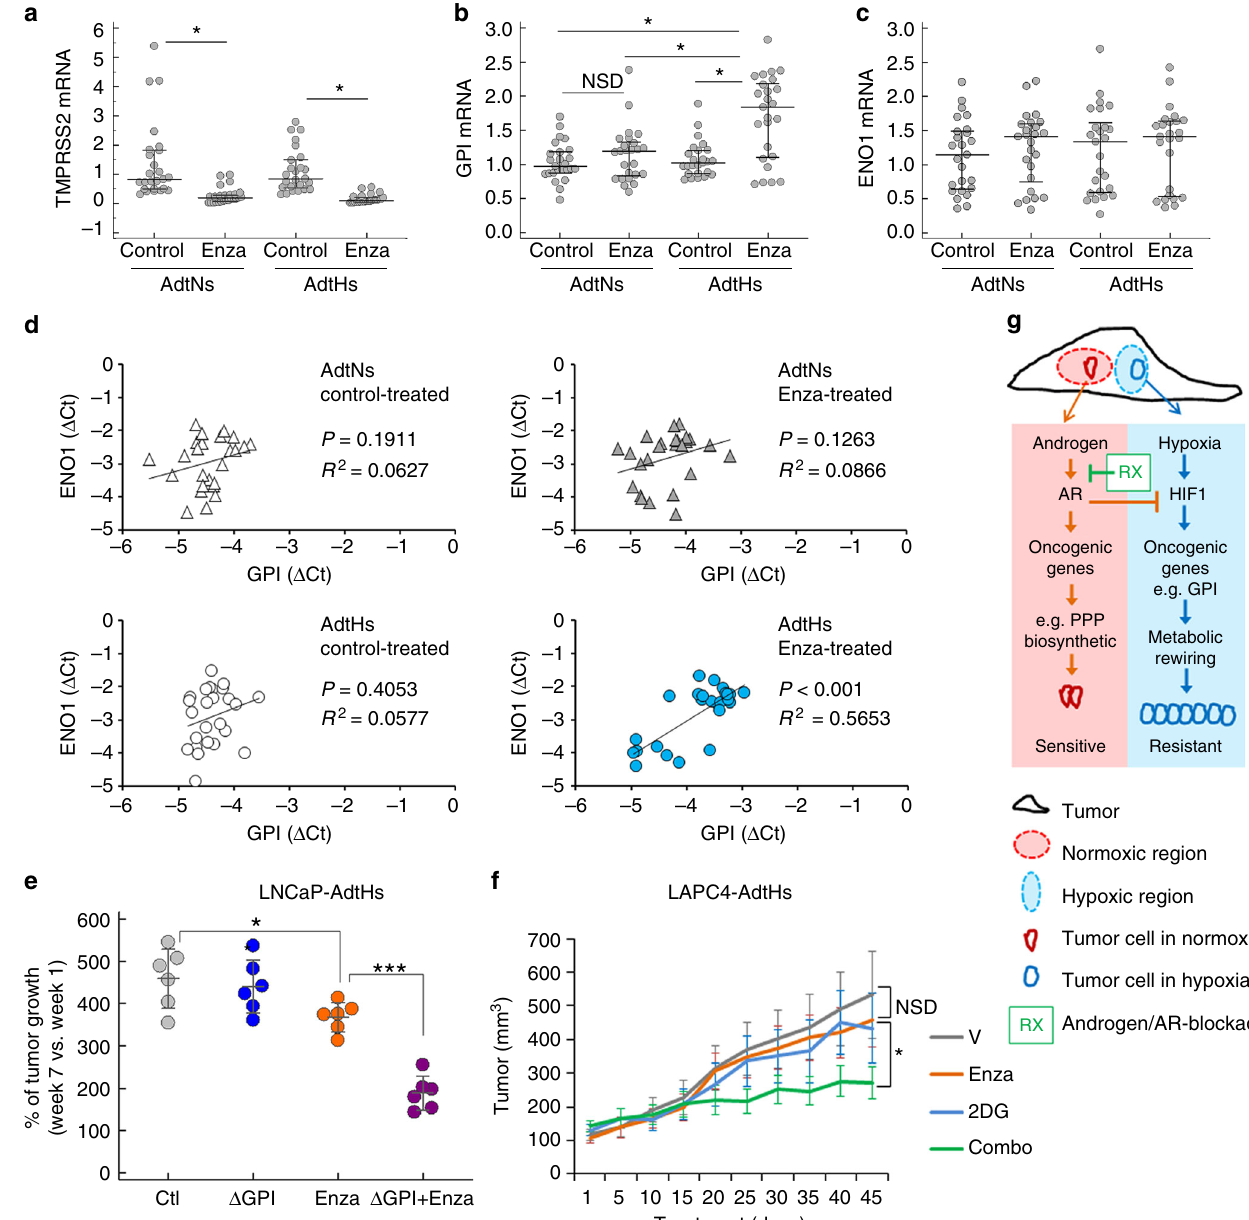
Fig. 7 GPI reduces the antitumor activity of enzalutamide in vivo. a – c Xenograft tumors from LNCaP AdtNs or AdtHs cells in Fig. 1g were cut into small pieces and used for RNA isolation, cDNA synthesis, and qRT-PCR. On average, 4 different locations (4 pieces) of each tumor were sampled, the sample size for each group (solvent or enzalutamide-treated AdtNs or AdtHs) is 25 ( n = 25). The mRNA expression of TMPRSS2 ( a ), GPI ( b ), and ENO1 ( c ) in each tumor piece (dot) is relative to the average of AdtNs tumors from solvent-treated control mice. Median (center line) ± 25 percentile, n = 25, * P < 0.05, two-sided t -test in a or repeated measure ANOVA in b . d The correlation between ENO1 and GPI mRNA expression in each tumor piece, grouped by AdtNs vs. AdtHs and by control-treated vs. enzalutamide. The P -value and R 2 were calculated by linear regression, n = 25. e Antitumor effect of enzalutamide in vivo with/without GPI. LNCaP-AdtHs cells with CRISPR/Cas9 knockout of GPI ( Δ GPI) or negative control were injected subcutaneously to male nude mice. After the tumors were palpable, mice were treated with vehicle (Ctl) or enzalutamide for 7 weeks. Tumor volume was followed by digital caliper. The % of growth for each tumor (post-treatment/pre-treatment) is shown as mean (center line) ± s.d. n = 6, * P < 0.05, *** P < 0.01, two-sided t -test. f Antitumor effect of enzalutamide in vivo in the presence/absence of glycolysis inhibitor 2DG. LAPC4-AdtHs cells were injected subcutaneously to male nude mice. After the tumors were palpable (~100 mm 3 ), mice were treated with vehicle (V), enzalutamide, 2DG, or enzalutamide + 2DG for 6 weeks. The tumor volume is mean ± s.d. n = 6, * P < 0.05, NSD, two-sided t -test and/or repeated measures ANOVA. g Schematic diagram of the negative regulation of hypoxia/HIF1 gene expression, e.g., GPI, by androgen/AR, leading to hypoxia-induced adaptive resistance to androgen/AR-targeted therapy (conditional androgen/AR-independence and therapy